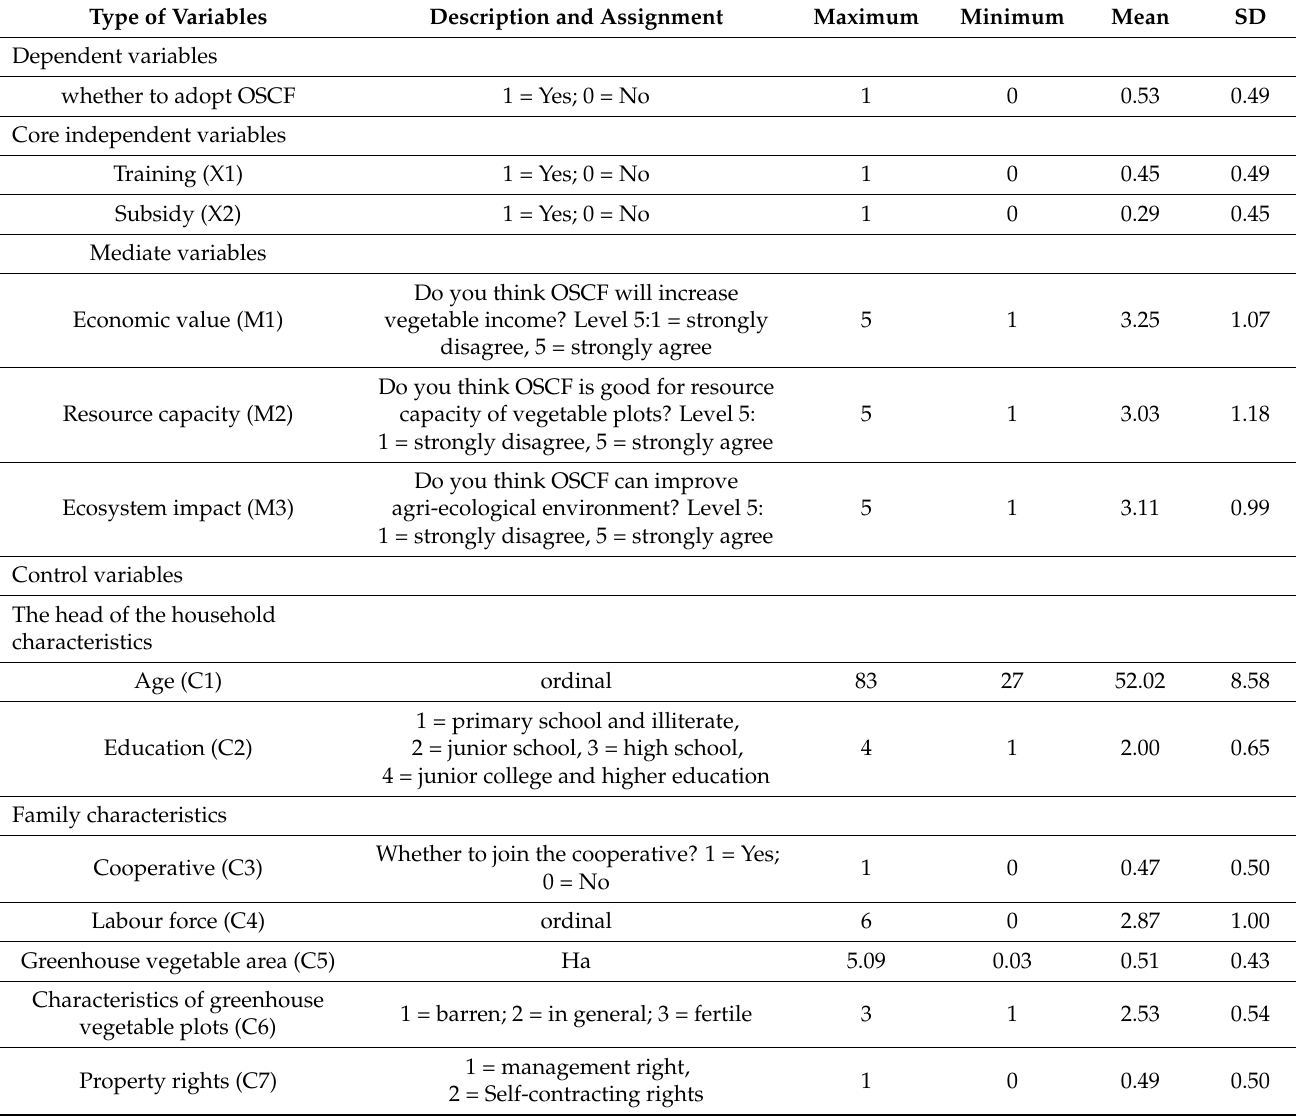
Table 1. Variables and descriptive